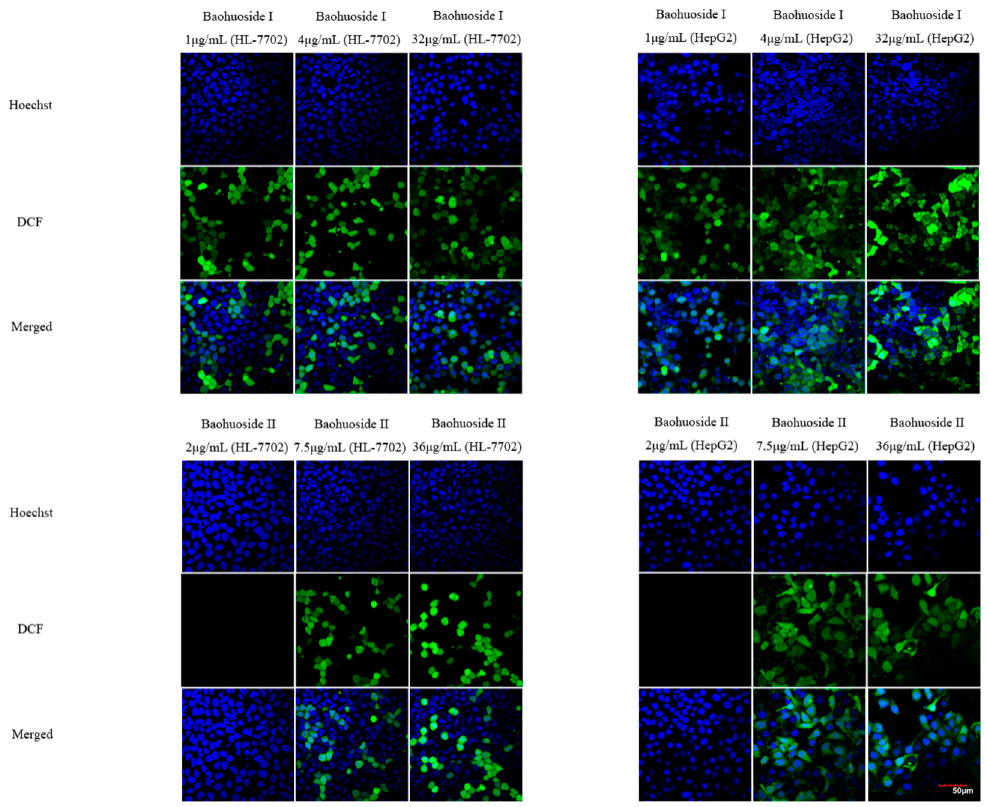
Figure 5. Effects of 2 ″ - O -rhamnosyl icariside II, baohuoside I and baohuoside II on the fluorescence intensity of DCF in HL-7702 and HepG2 cells. Notes : Except baohuoside II at low concentration,